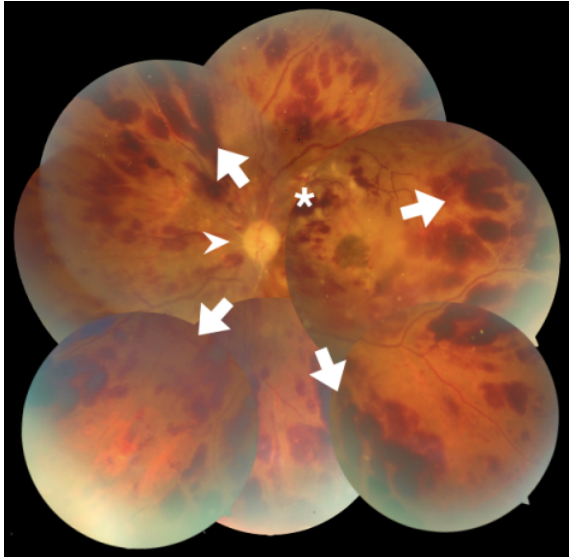
Figure 1: Montage image of the left retina shows optic disc pallor (arrowhead). Extensive superficial retinal hemorrhages are seen (arrows) and the retinal veins are dilated and tortuous consistent with central retinal vein occlusion. Few cotton wool spots are seen superotemporal to the optic disc (asterisk). Macular edema can also be made